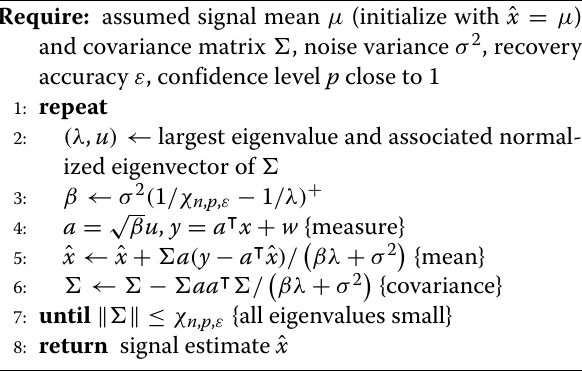
Algorithm 1 Info-Greedy Sensing for Gaussian signals